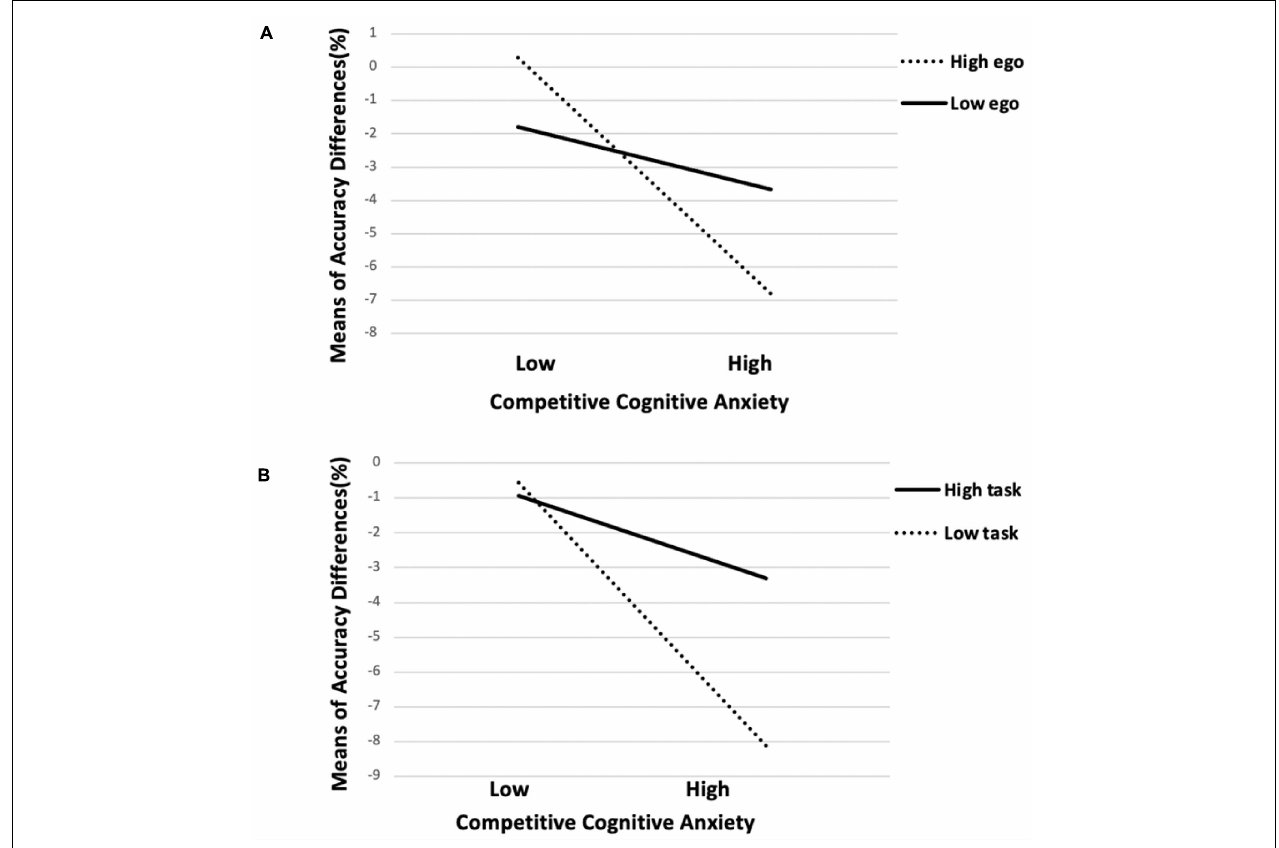
FIGURE 2 | The associations of competitive cognitive anxiety with accuracy differences between two sessions (S2–S1) among athletes with high and low ego-orientations (A) and high and low task-orientations (B) . Note. High ego, high ego orientation; Low ego, low ego orientation; High task, high task orientation; and Low task, low task